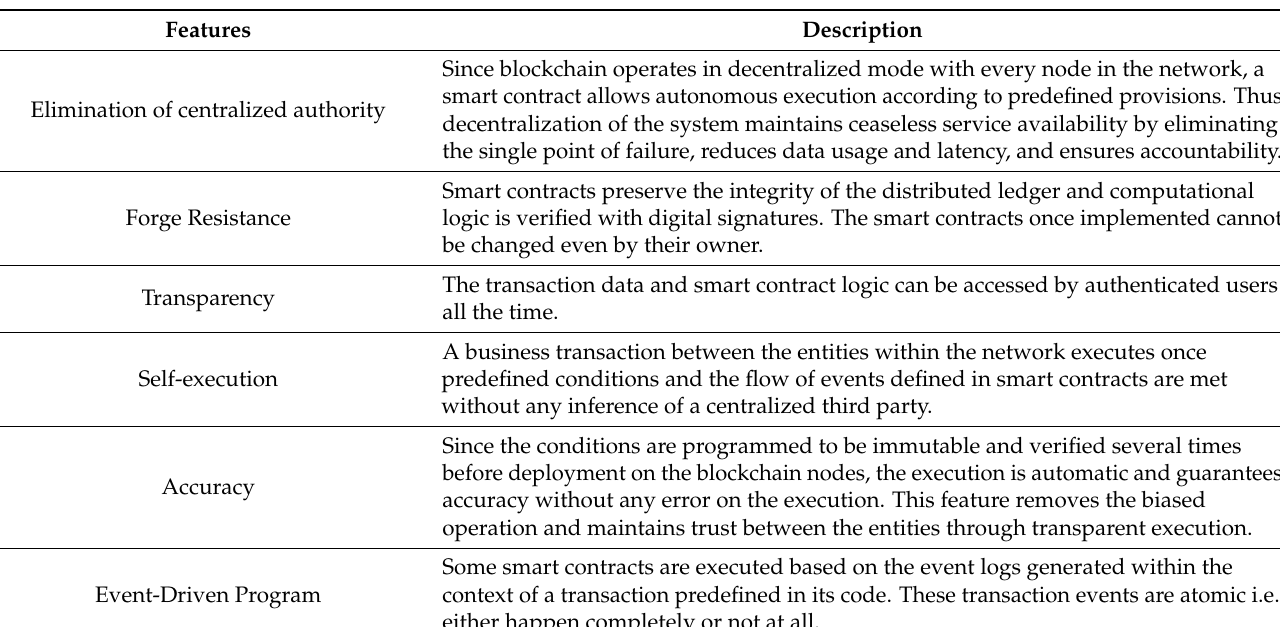
Table 1. Characteristics of Blockchain-based Smart